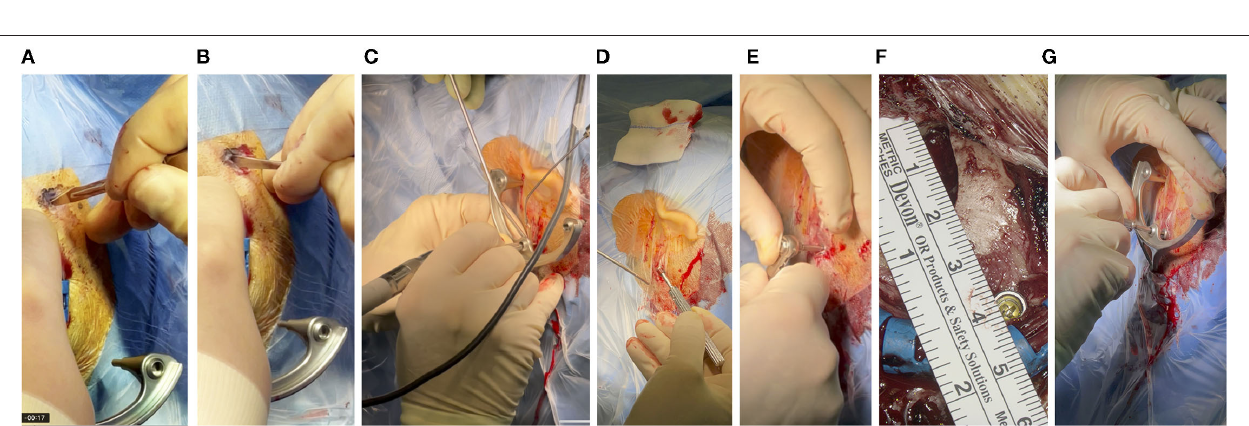
FIGURE 2 | (A) Prior to disinfection of the surgical field, marking the mastoid tip (star shaped), drawing the orbitomeatal line (dashed) and line perpendicular (solid) can help to position the frame. (B) A non-sterile 3d-printed dummy frame can be useful to mark the incision points and the location where the bone screw shall be placed. (C) Optionally, if a navigation system has been set up, the bone thickness at the designated screw position can be documented (in this case 6.9 mm). (D) If a preoperative scan is available, the bone thickness can be visualized. Visible are the artifacts due to the air-filled mastoid cells and the lower bone thickness at the sigmoid sinus.